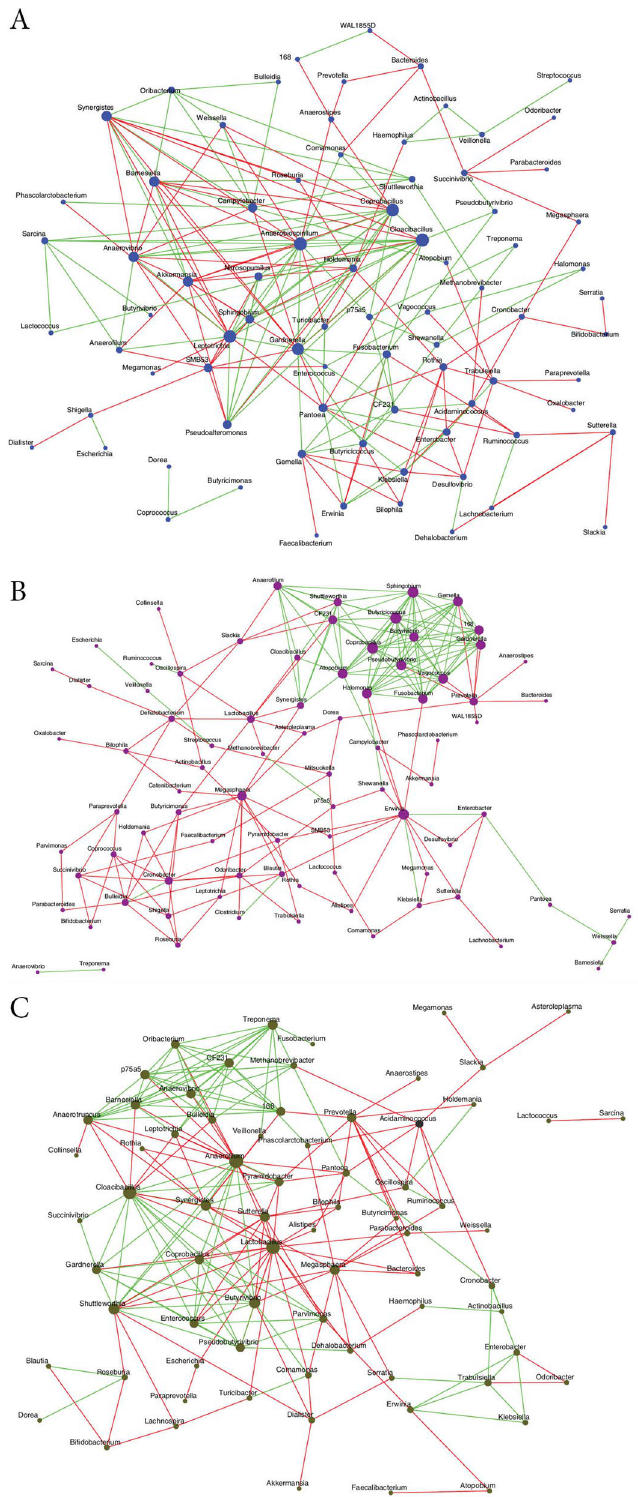
Figure 3. Significant co-occurrence and co-exclusion relationships at genus level in the gut microbiomes of healthy controls (HC, n = 30), Type 2 Diabetes mellitus (T2DM, n = 24) and Diabetic Retinopathy (DR, n = 28) individuals. Interaction of bacterial genera in the gut microbiomes of healthy controls ( A ), Type 2 Diabetes mellitus ( B ) and Diabetic retinopathy ( C ) individuals (based on correlation of genera-level abundance). The node sizes in the network correspond to their degree of interaction. The positive and negative correlations / interactions are indicated with green and red edges